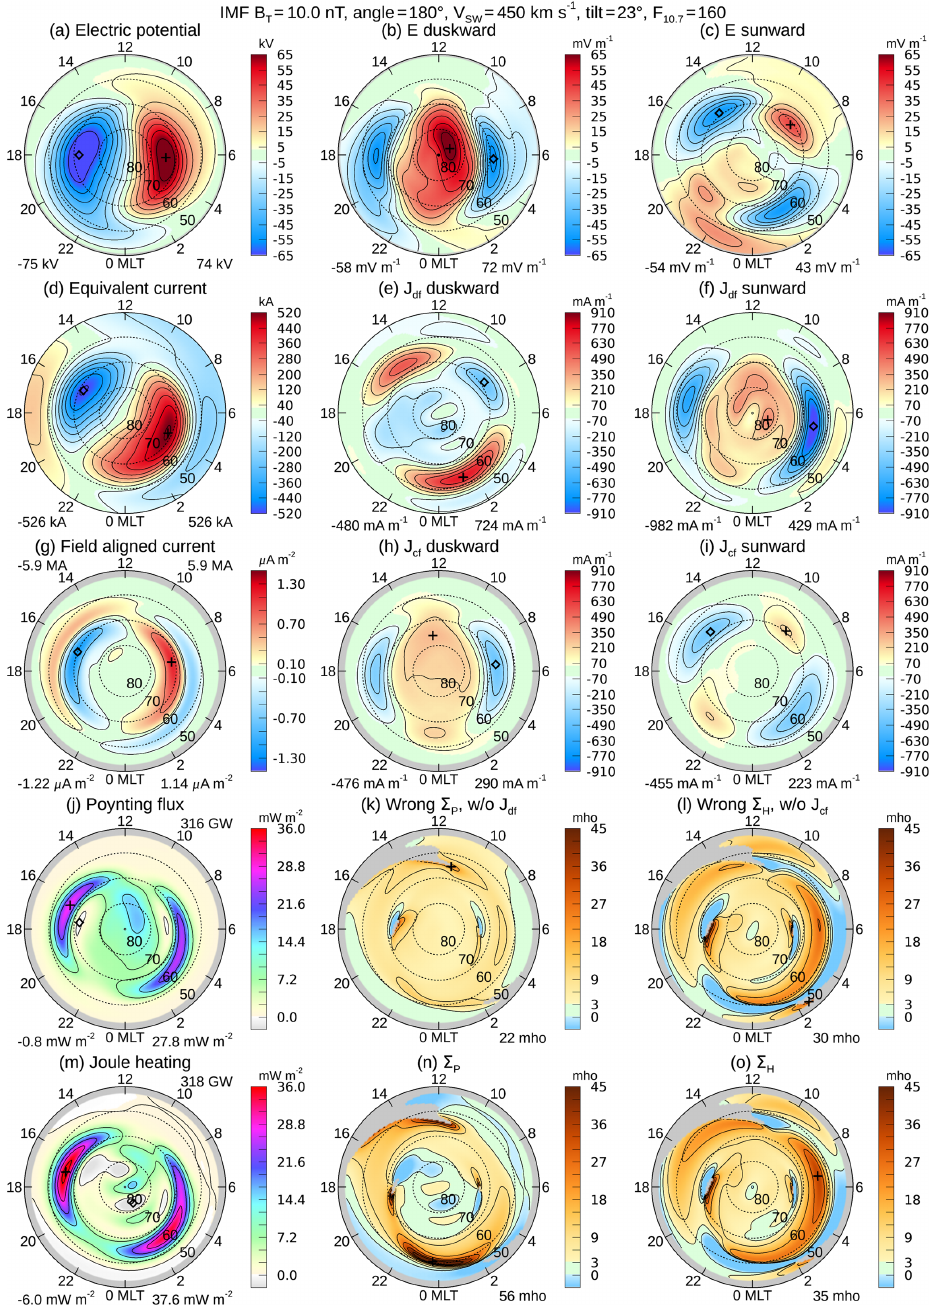
Figure 3. Conductivity input data and results for the same conditions as in Fig. 1, except that the dipole tilt angle is for summer conditions. The IMF B T magnitude is 10nT at 180 ◦ , the solar wind velocity is 450km s − 1 , the F 10 . 7 index is 160sfu, and the dipole tilt angle is + 23 ◦